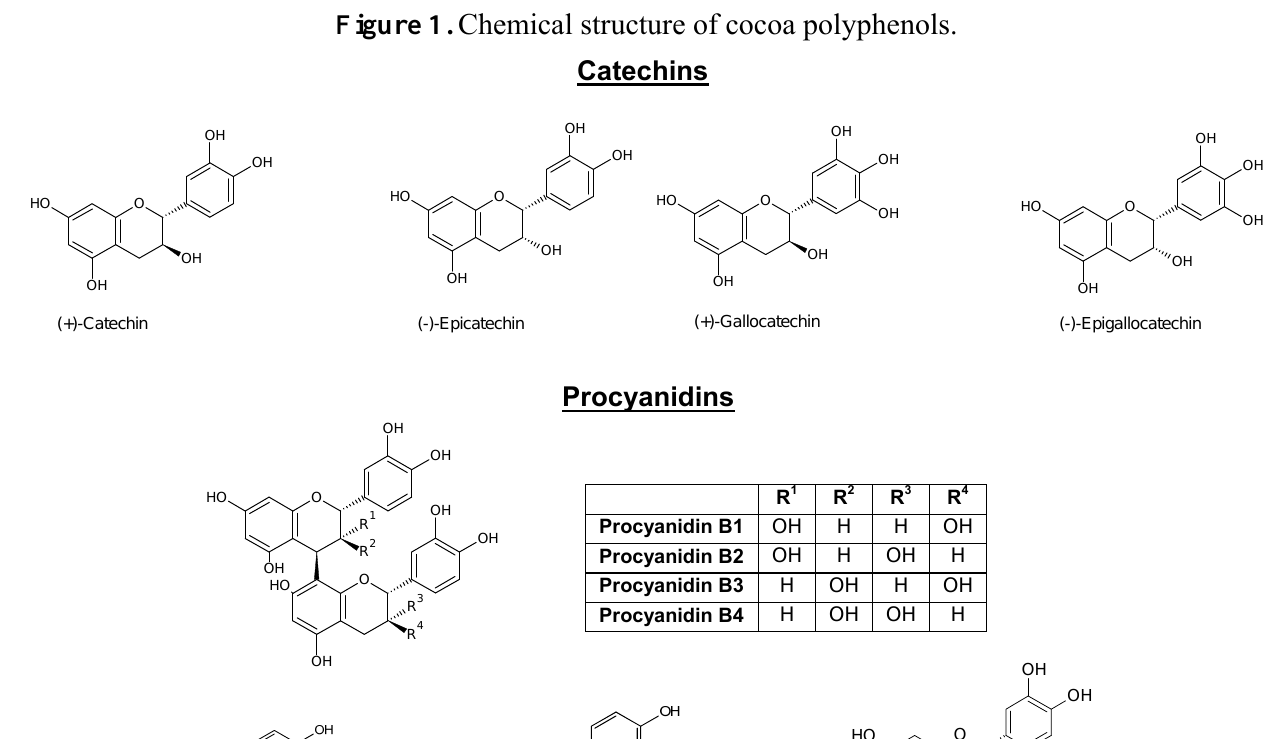
Figure 1. Chemical structure of cocoa